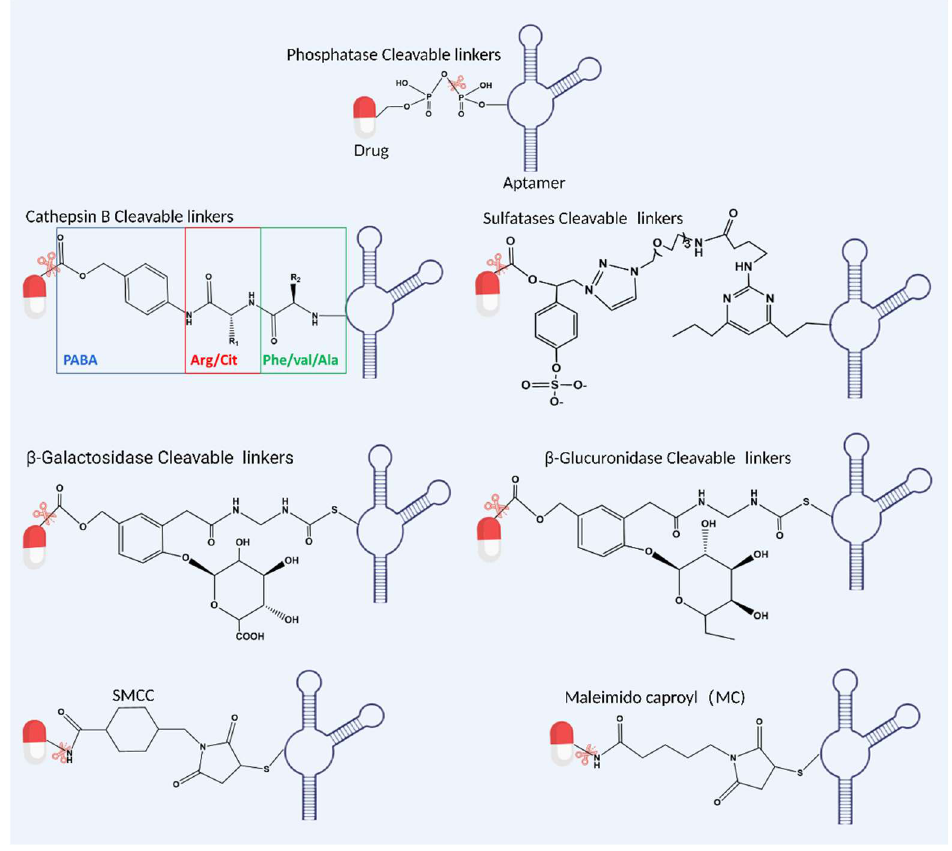
Figure 2. Scheme of examples of various aptamer–drug conjugates through chemical linkers. Created with BioRender.com.